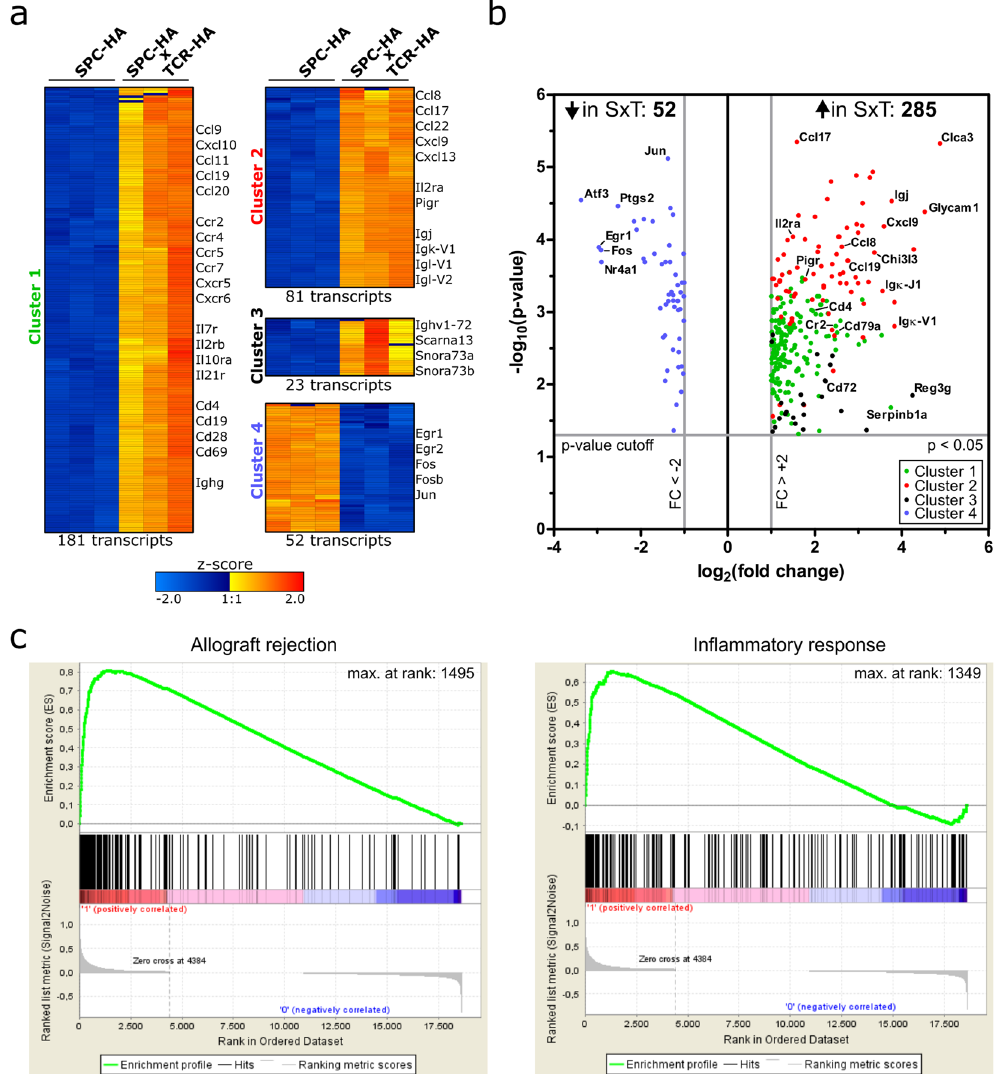
Figure 1. Transcriptional profile of whole lung tissue from SPC-HAxTCR-HA vs. SPC-HA mice. RNA from lung tissue of SPC-HA and SPC-HAxTCR-HA mice (n = 3/group) was isolated and samples were individually analyzed on whole transcriptome microarrays. Differential expression was analyzed by one-way ANOVA with p-value cutoff p < 0.05 and fold change cutoff FC > ± 2 comparing SPC-HAxTCR-HA vs. SPC-HA. Fold changes were calculated based on group-average of signal intensities. ( a ) Normalized log 2 signal intensities of significantly regulated transcripts from each individual microarray replicate were clustered according to k-means clustering (cluster 1–4). Color code represents z-score. Gene symbols of selected prominent transcripts within each cluster are stated. ( b ) Volcano s catter plot of significantly regulated transcripts with cluster assignment referring to ( a ). Gene symbols of selected prominent transcripts are stated. SxT = SPC- HAxTCR-HA; FC = fold change. ( c ) Gene Set Enrichment Analysis (GSEA) for canonical hallmark gene sets from the Molecular Signature Database (MSigDB) of microarray data comparing SPC-HAxTCR-HA vs. SPC-HA (FDR <